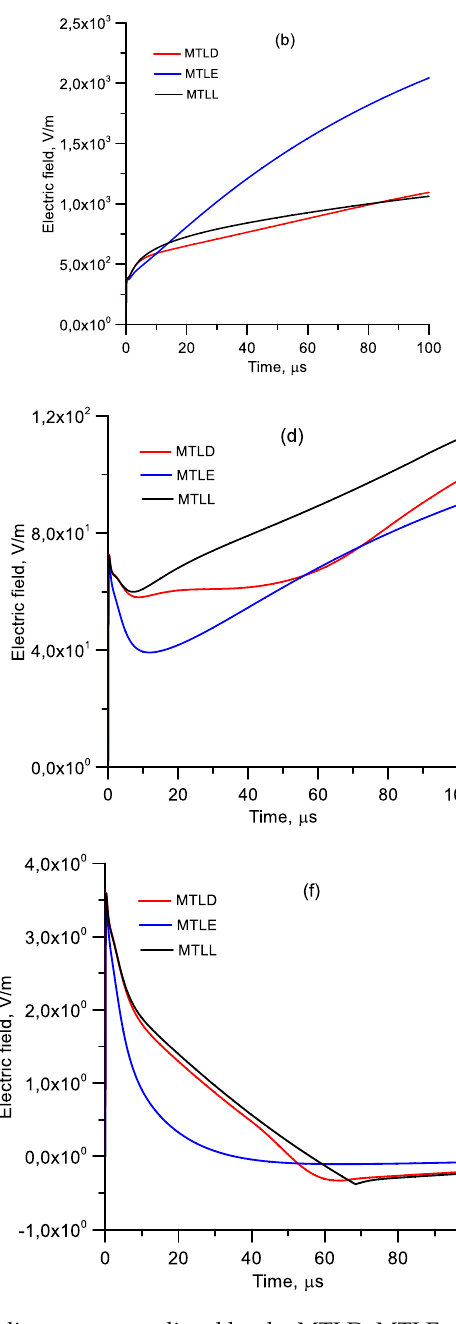
Figure 5. Electric fields of subsequent return strokes at different distances as predicted by the MTLD, MTLE and MTLL models. ( a ) 50 m, ( b ) 1 km, ( c ) 2 km, ( d ) 5 km, ( e ) 10 km and ( f ) 100 km. In the MTLE model, λ = 2 km and, in the MTLL model, H = 10 km are used as model parameters. The return stroke speed is assumed to be constant and equal to 1.5 × 10 8 m/s.